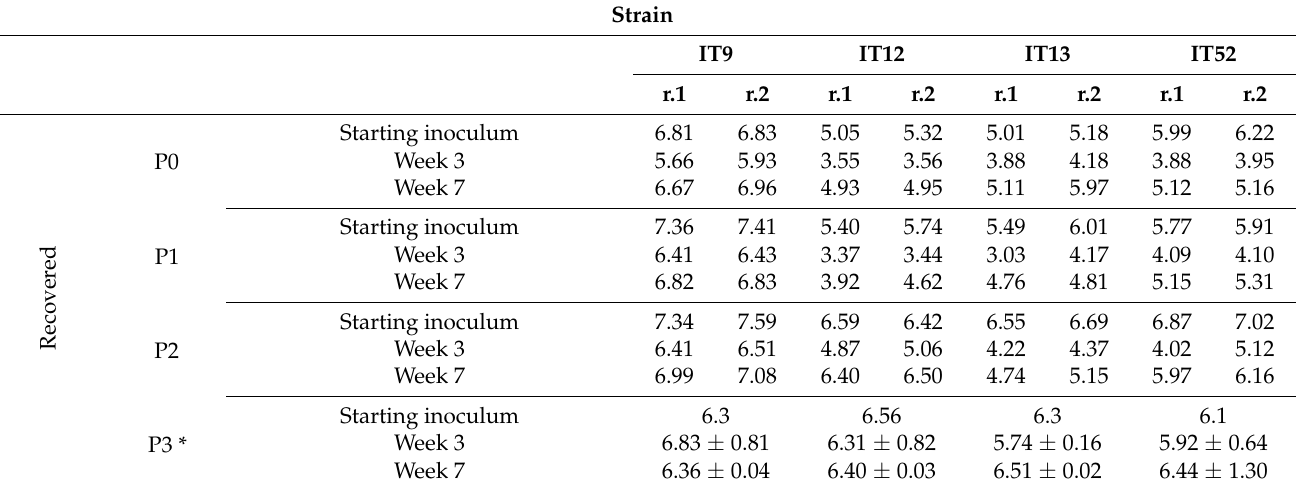
Table 2. Recovered Log 10 GC/mL of HEV-RNA from first cell cultivation of virus from faeces (P0), following passages P1, P2 and P3 (viral stocks on growth medium without FBS) obtained from cell culture supernatants at different time points. The values of the two replicates (r.1, r.2) of P0, P1 and P2 are reported, whereas for P3 a mean of five replicates is reported (*).